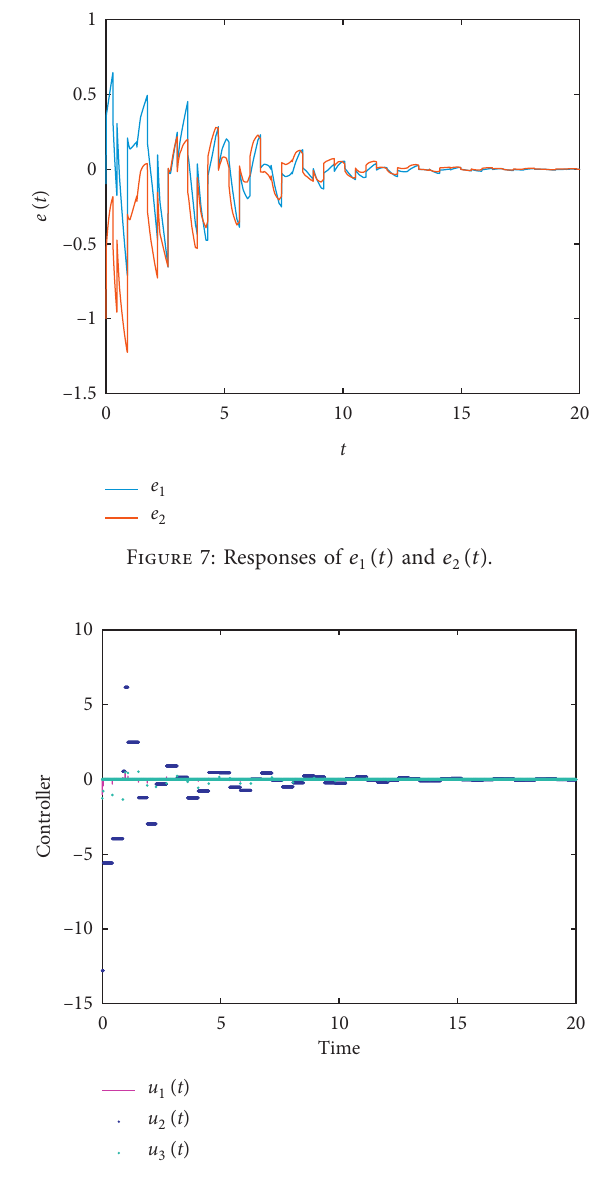
Figure 8: The dynamics of control